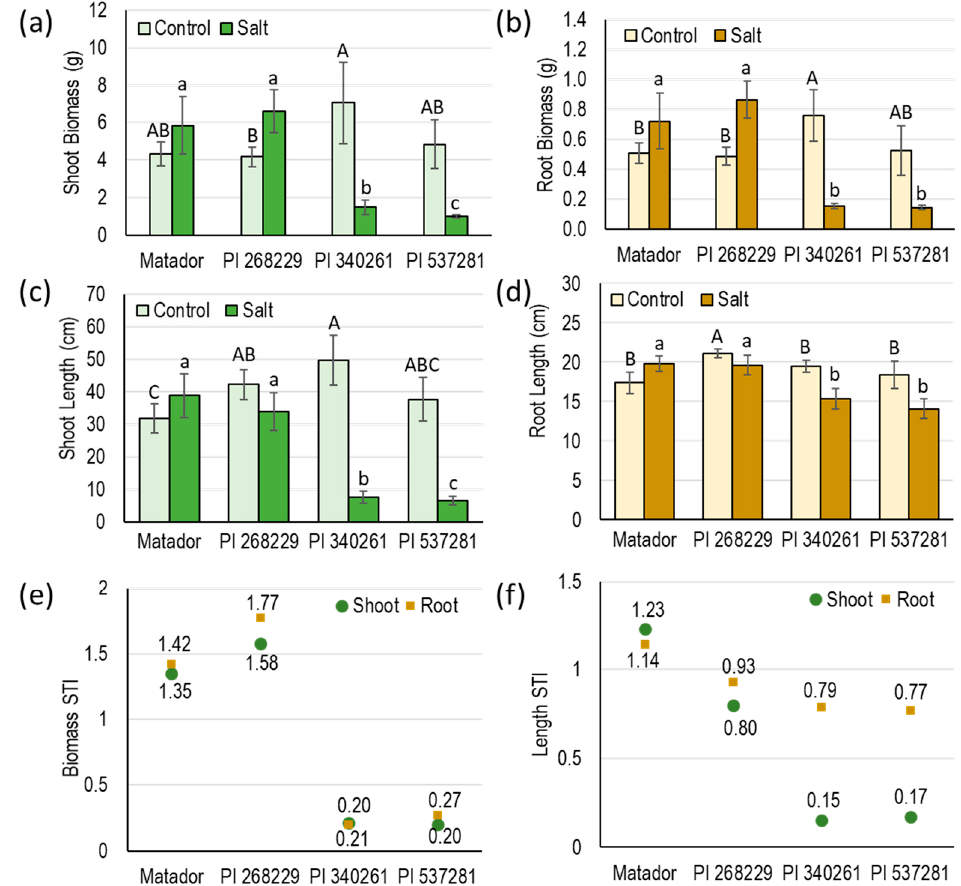
Figure 2. Performance of four guar genotypes under control and salinity conditions. ( a ) Shoot biomass. ( b ) Root biomass. ( c ) Shoot length. ( d ) Root length. ( e ) Salt tolerance index (STI) for the shoot and root biomass. ( f ) STI for the shoot and root length. Capital letters signify significant differences under control conditions, while lower case letters signify significant differences under the saline condition ( p ≤ 0.05) ( n = 3). Error bars represent standard errors.